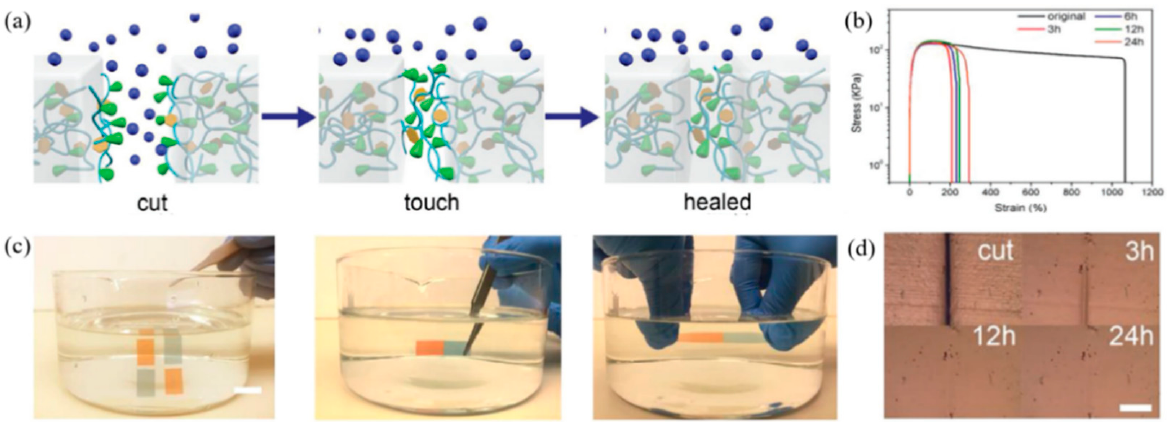
Figure 20. The self-healing of fluorinated elastomer using dipole–dipole interaction; ( a ) healing mechanism underwater, ( b ) stress–strain curves of healed samples with various healing times at room temperature, ( c ) healing demonstration underwater, and ( d ) optical images of damaged and healed samples [109]. Adapted from [109], with permission from John Wiley and Sons.